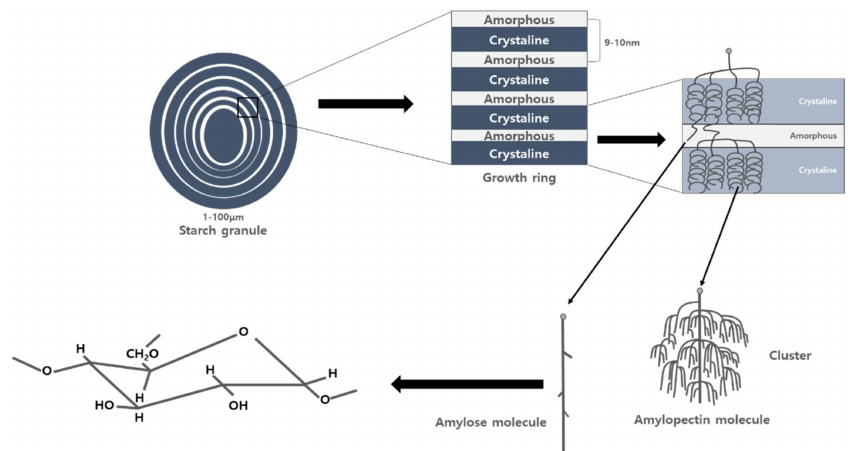
Figure 4. Schematic diagram of the various structural levels of starch granules and the relationship between amylose and amylopectin. Source: This schematic is cited from Bul é on et al.